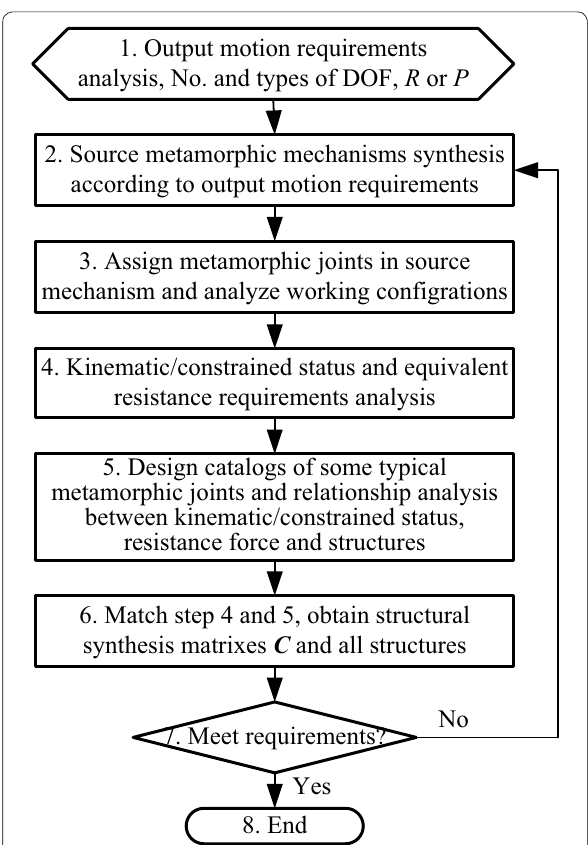
Figure 4 The whole family of 1-DOF groups consisting of n p